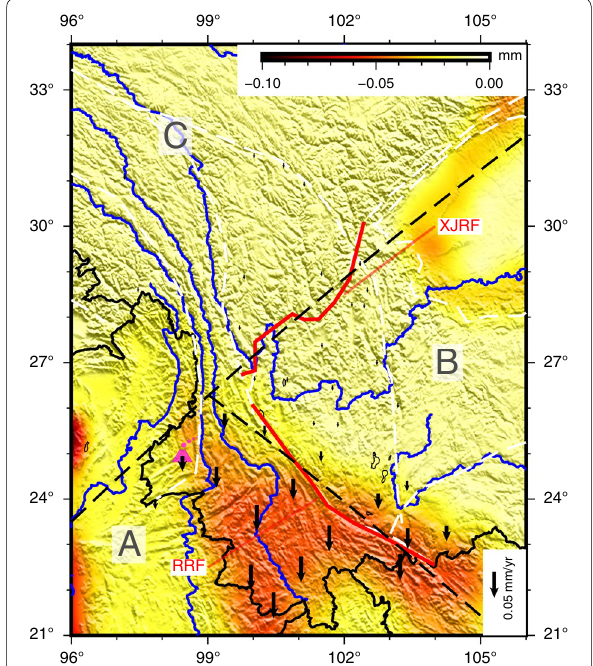
Fig. 6 Vertical rates deduced by the deposition accumulation rates on the surface of the crust. The colors denote the vertical rates ( V d ) deduced by the deposition rates. The black arrows denote the V d at the position of the continuous stations used in this study. The blue curves denote the permanent rivers of the study area. The meaning of the symbols and lines is the same as in Fig.